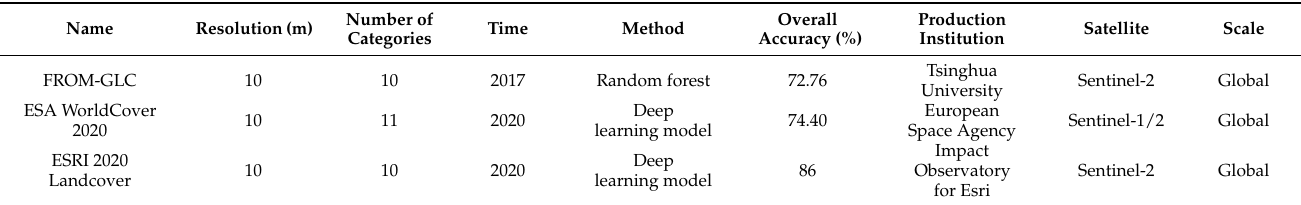
Table 1. Main parameters of different products.